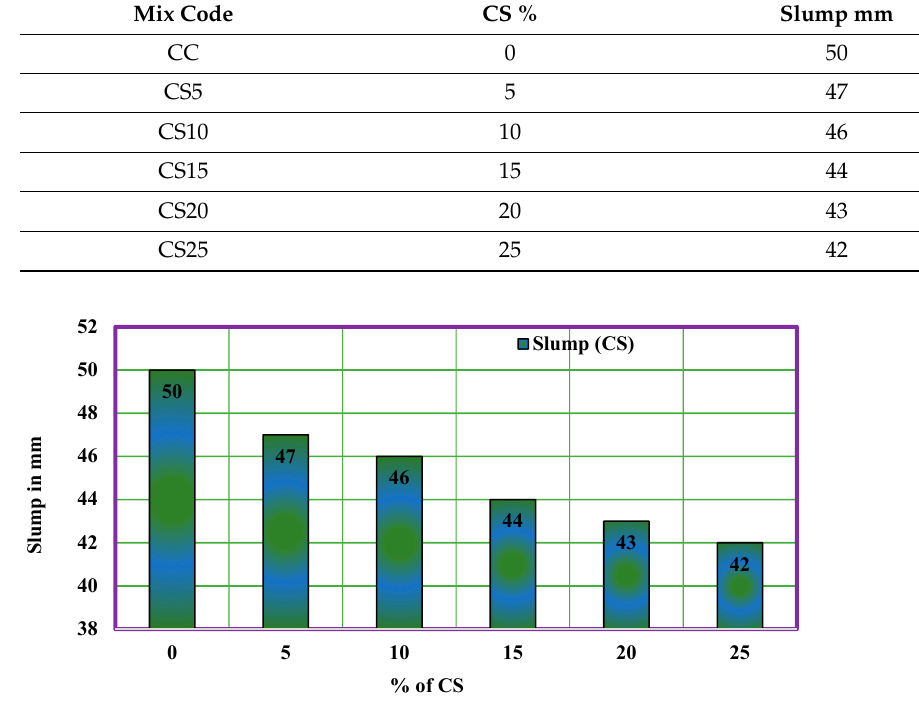
Figure 3. Slump of CS concrete.